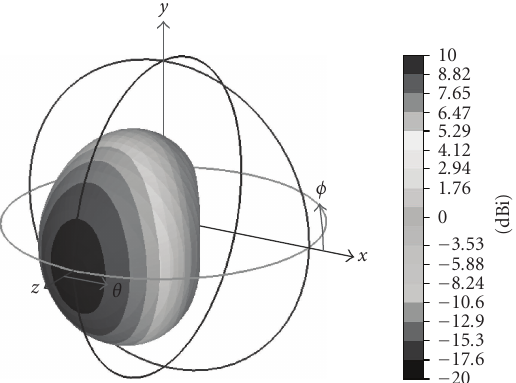
Figure 15: Radiation pattern at 0.9